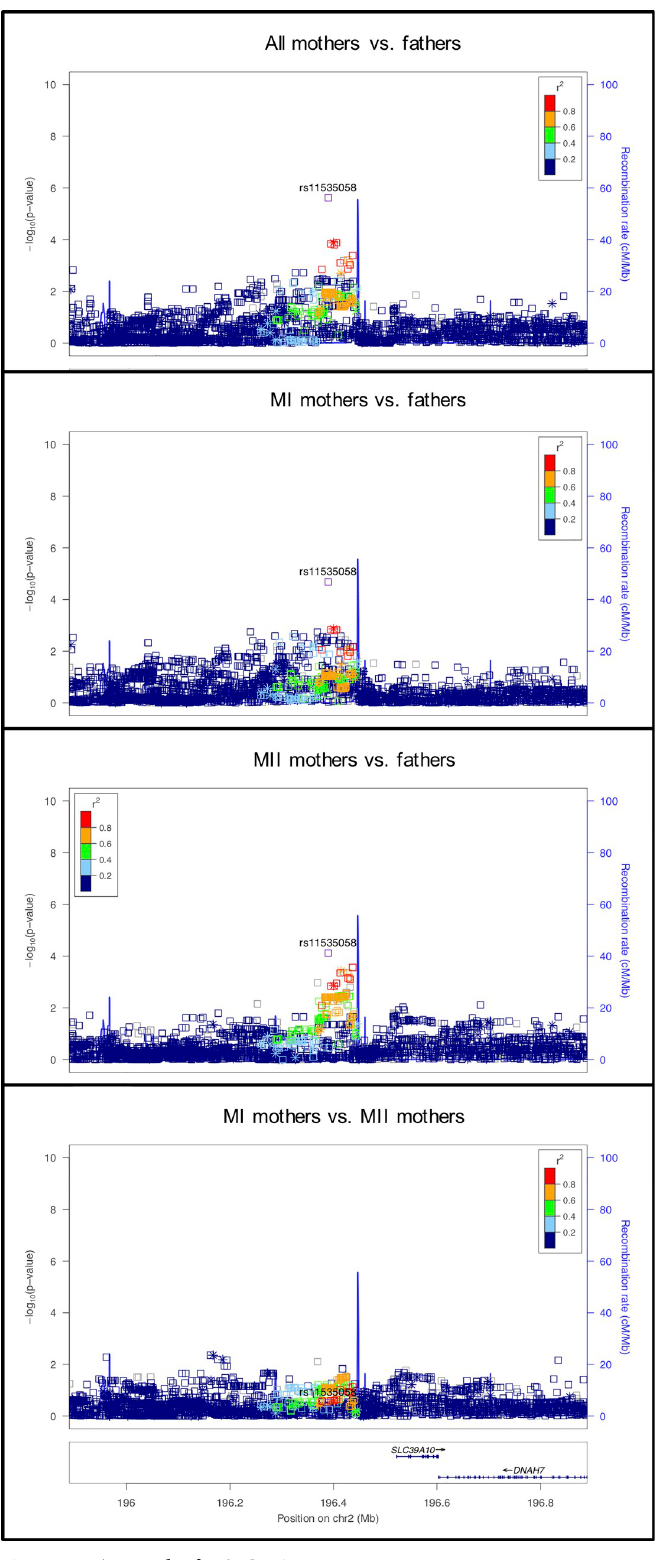
Fig 7. LocusZoom plot for SLC39A10